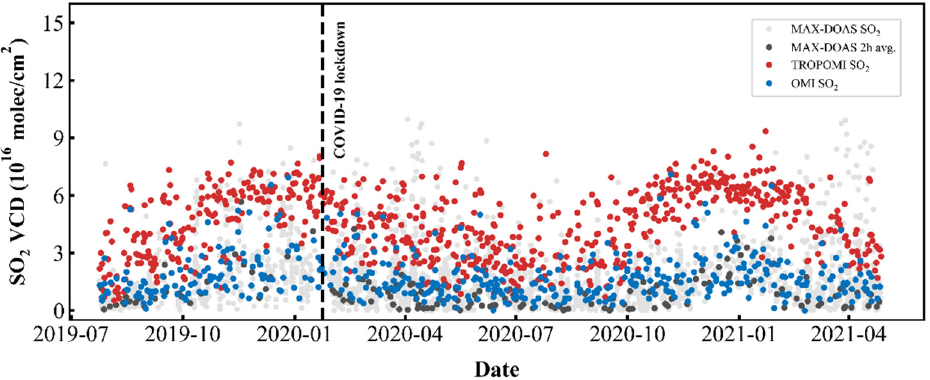
Figure 6. Same as Figure 2, but for SO 2 .